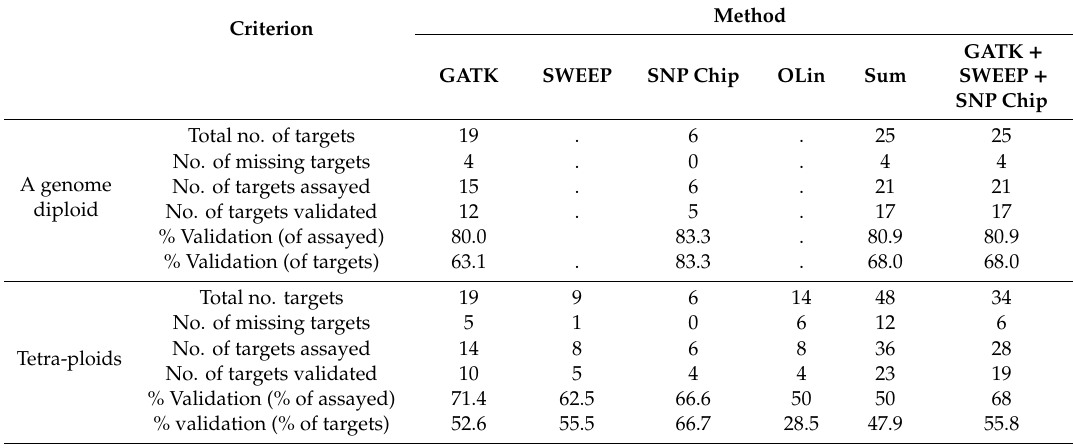
Table 4. Summary of percentage validation of SNPs from di ff erent methods.